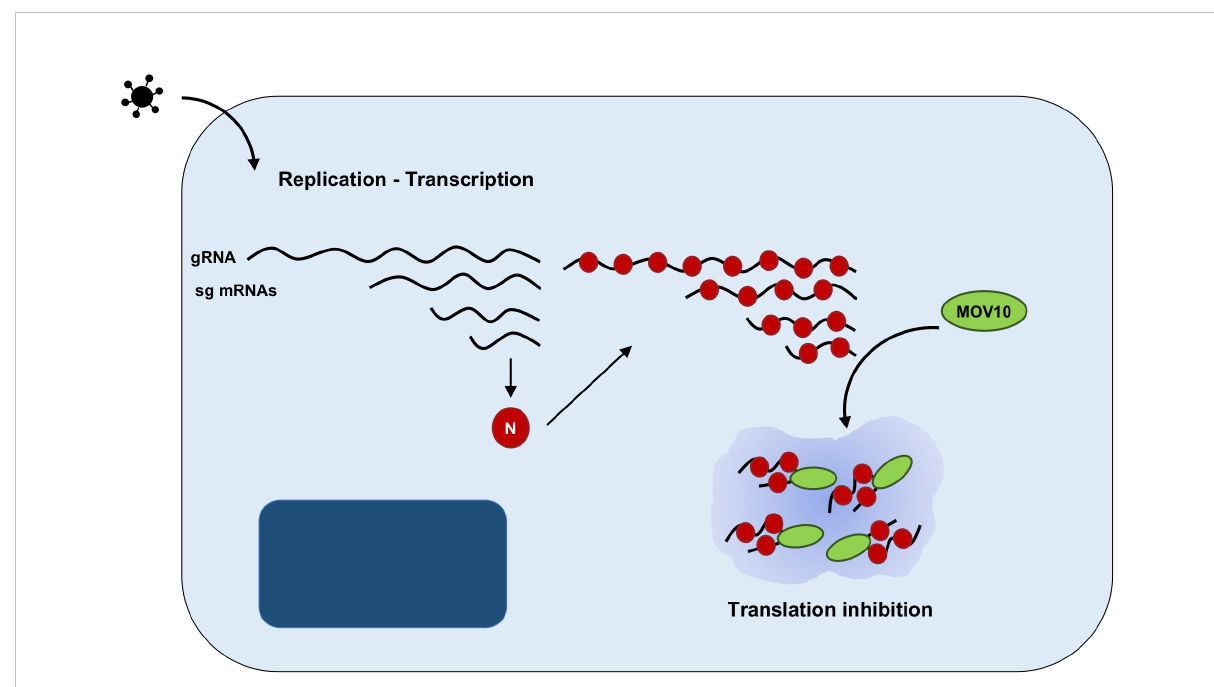
FIGURE 3 Proposed model of MOV10 antiviral function during MERS-CoV infection. Schematic representation of an infected cell, including nucleus (dark blue) and cytoplasm (light blue). CoV replication and transcription leads to the synthesis of a nested set of viral RNAs, both viral genome (gRNA) and subgenomic mRNAs (sgmRNAs). N protein is translated from the subgenomic RNA and binds to viral RNAs. The RNA-dependent interaction between N protein and MOV10 may lead to the accumulation of viral RNAs and N protein in cytoplasmic RNPs, inhibiting viral